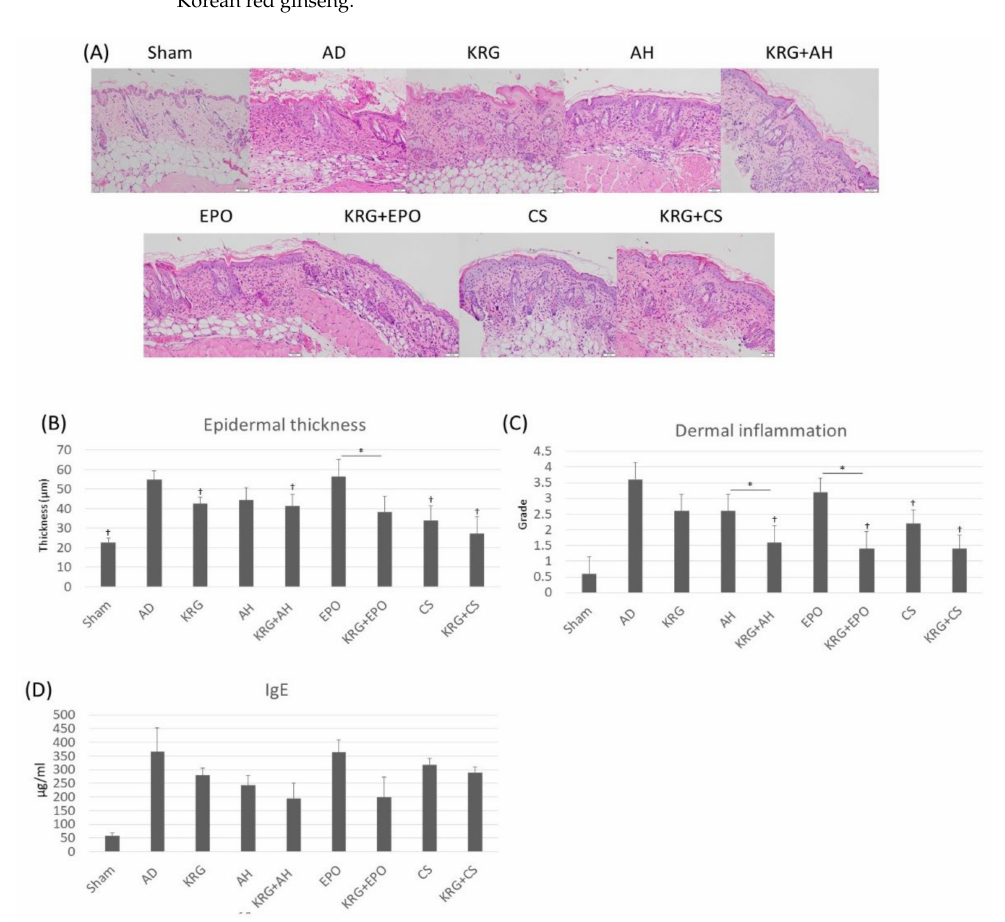
Figure 2. After the administration of KRG and conventional systemic therapeutics, the dermal inflammation and acanthosis was inhibited in TNCB-induced AD mouse model. ( A ) Representative images of histopathological analysis in each treatment group (H&E, 200x). Scale bar, 50 µ m. ( B ) The bar graph of epidermal thickness in each group. ( C ) The bar graph of dermal inflammation in each group. ( D ) The bar graph of the serum total IgE in each group. † indicates p < 0.05 compared to the AD group. * indicates p < 0.05 in AH versus KRG + AH, CS versus KRG + CS, EPO versus KRG + EPO, respectively. All the data were presented as the mean and the standard error of the mean. Abbreviation: AD, atopic dermatitis; AH, antihistamine; CS, cyclosporine; EPO, evening primrose oil; KRG, Korean Red ginseng; TNCB,